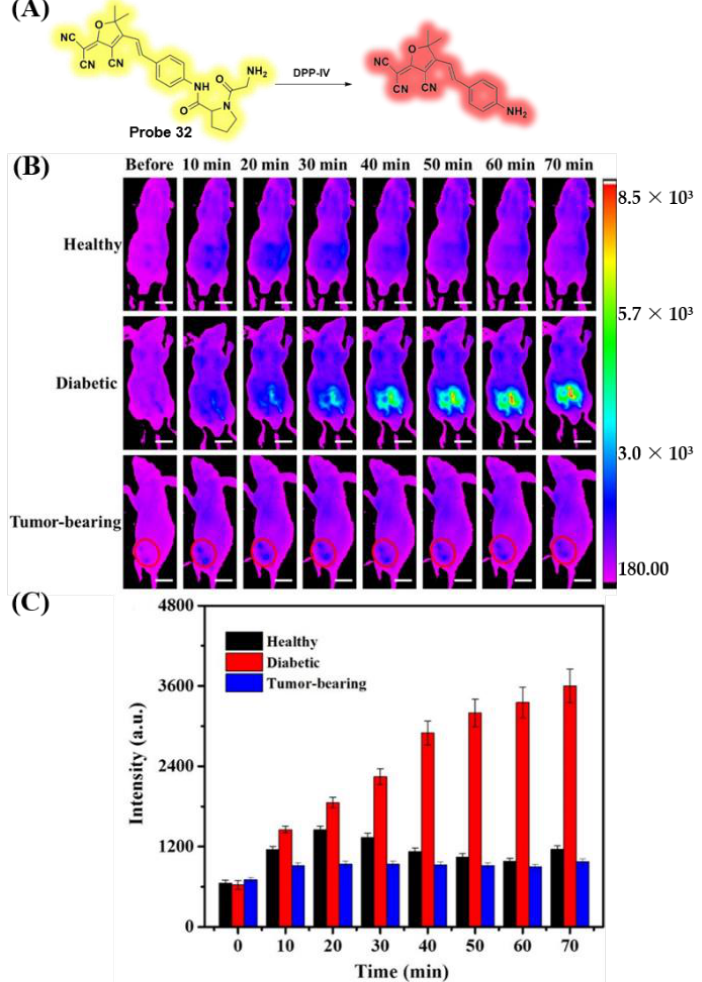
Figure 26. ( A ) Imaging mechanism of probe 31 ; ( B ) time-dependent fluorescence imaging of probe 31 (10 mM, 100 μL) in healthy, diabetic, and tumor -bearing mice planted with HepG2 cells; ( C ) fluorescence intensity at different times in ( B ). Conditions: λ ex = 470 nm, λ em = 590 – 700 nm. Adapted from Reference [121]. Copyright 2021, American Chemical Society.